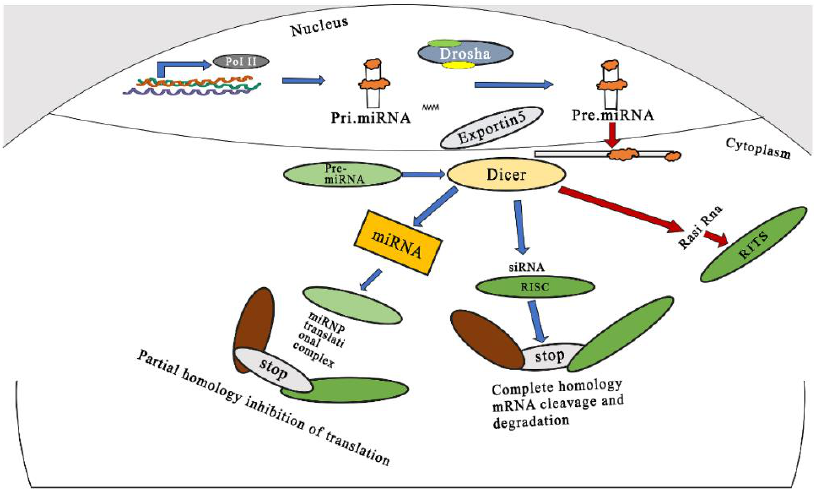
Figure 1. Schematic representation of mechanism of gene silencing by miRNAs and siRNAs. Adapted and modified from [12] under the Creative Commons